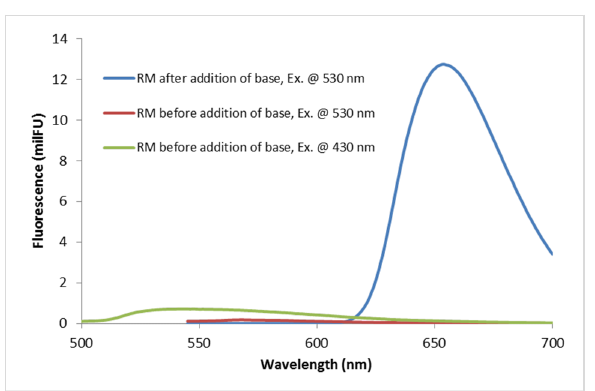
Figure 2: Fluorescence spectra of the photoborylation reaction mix- ture (RM). Ex. = excitation